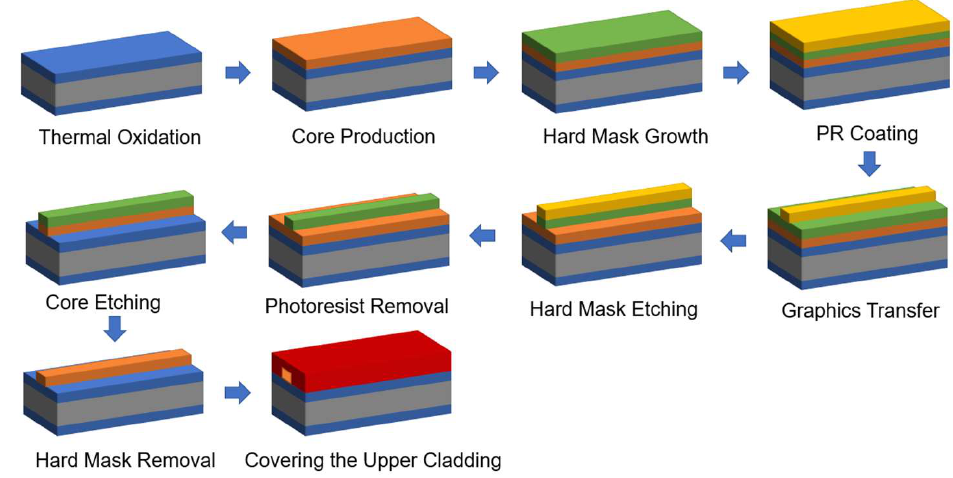
Figure 7. The fabrication process of the AWG.